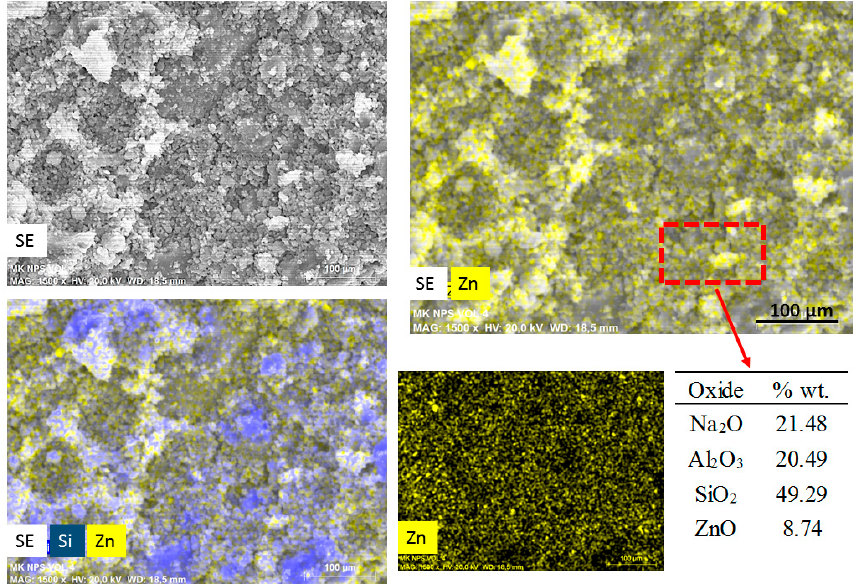
Figure 4. SEM images of secondary electros and EDS analysis for metakaolin-based paste with addition of nanospheres functionalized (mkSf).